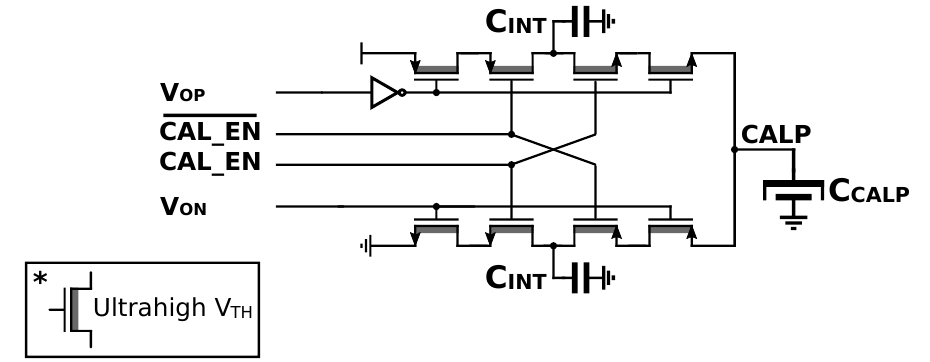
Figure 3. Transistor-level implementation of the self-calibration unit (single-ended shown for